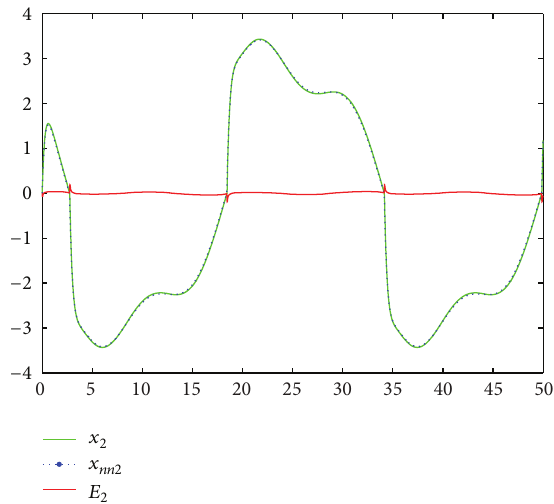
Figure 6: Identification result for system state 𝑥 2